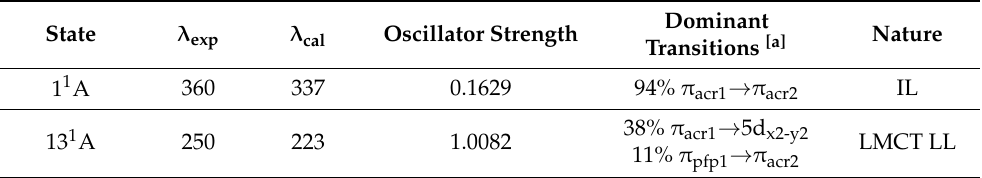
Table 3. Calculated wavelengths (nm), oscillator strength, dominant transitions (%) and nature of the excited singlet states in the absorption spectrum of complex 3 . State λ exp λ cal Oscillator Strength 1 1 A 360 337 0.1629 94% π acr1 → π acr2 IL 13 1 A 250 223 1.0082